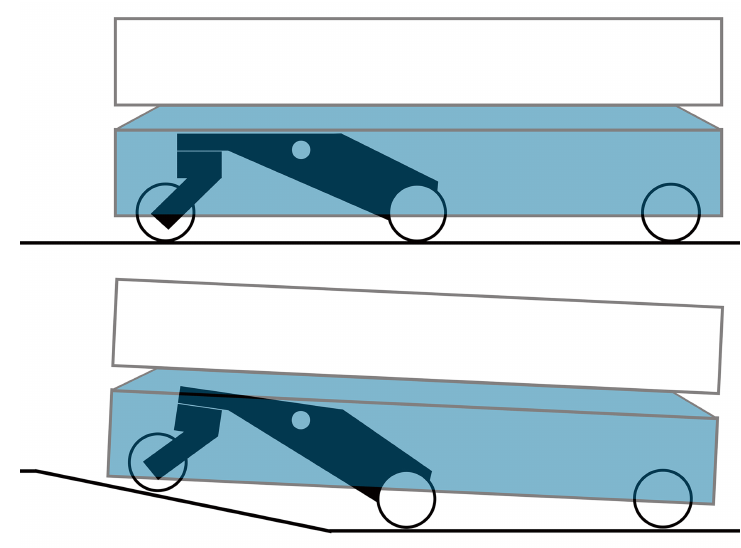
Figure 1. An overview of Phollower’s base construction.